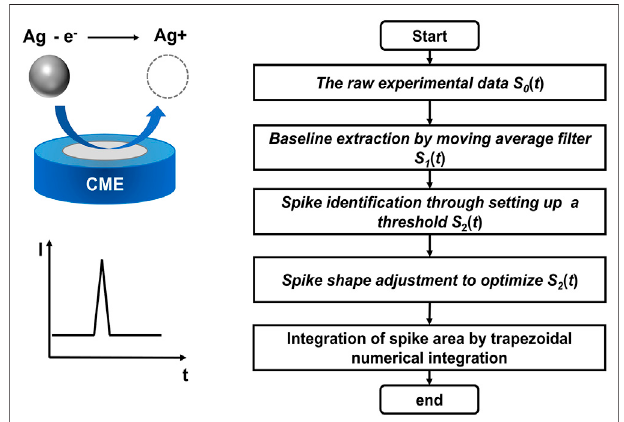
FIGURE1| Schemeofthespikedetectionalgorithmforautomateddata processing of AgNP oxidation in nano-impact electrochemistry. The diagram illustrates the direct oxidation of a AgNP during the impact to the surface of a carbon microelectrode (CME) and the corresponding oxidative spike.